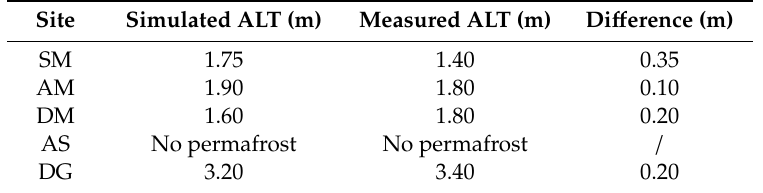
Figure 4. Comparison of the simulated and observed mean annual ground temperature profile for five sites: ( a ) site SM; ( b ) site AM; ( c ) DM; ( d ) AS; ( e ) DG. Table 4. Differences between simulated ALT and measured ALT for the five sites.